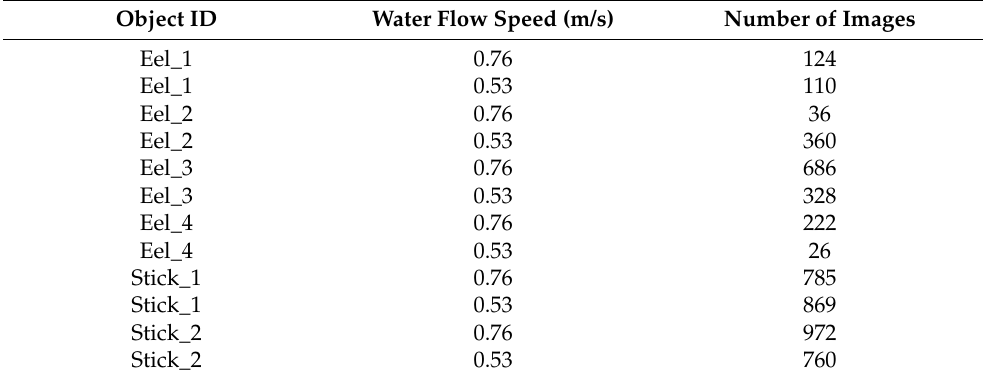
Table 2. Number of extracted images of eels and sticks in the laboratory experiments.